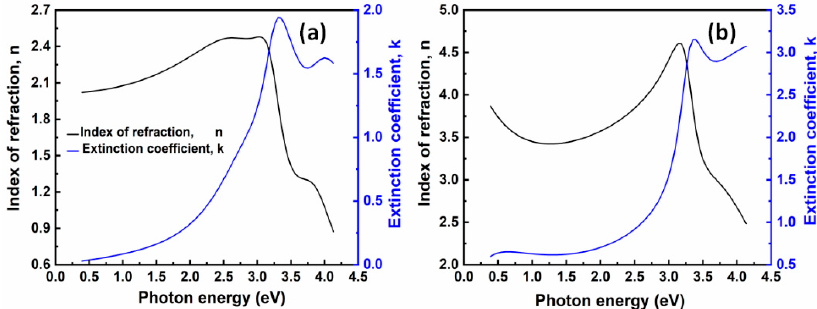
Figure 6. Estimated dispersion laws estimated of graphene oxide ( a ) and thermally reduced graphene oxide ( b ) films on SiO 2 / Si substrates by ellipsometry characterization. The curves represent the index of refraction (black lines) and the extinction coefficient (blue lines).